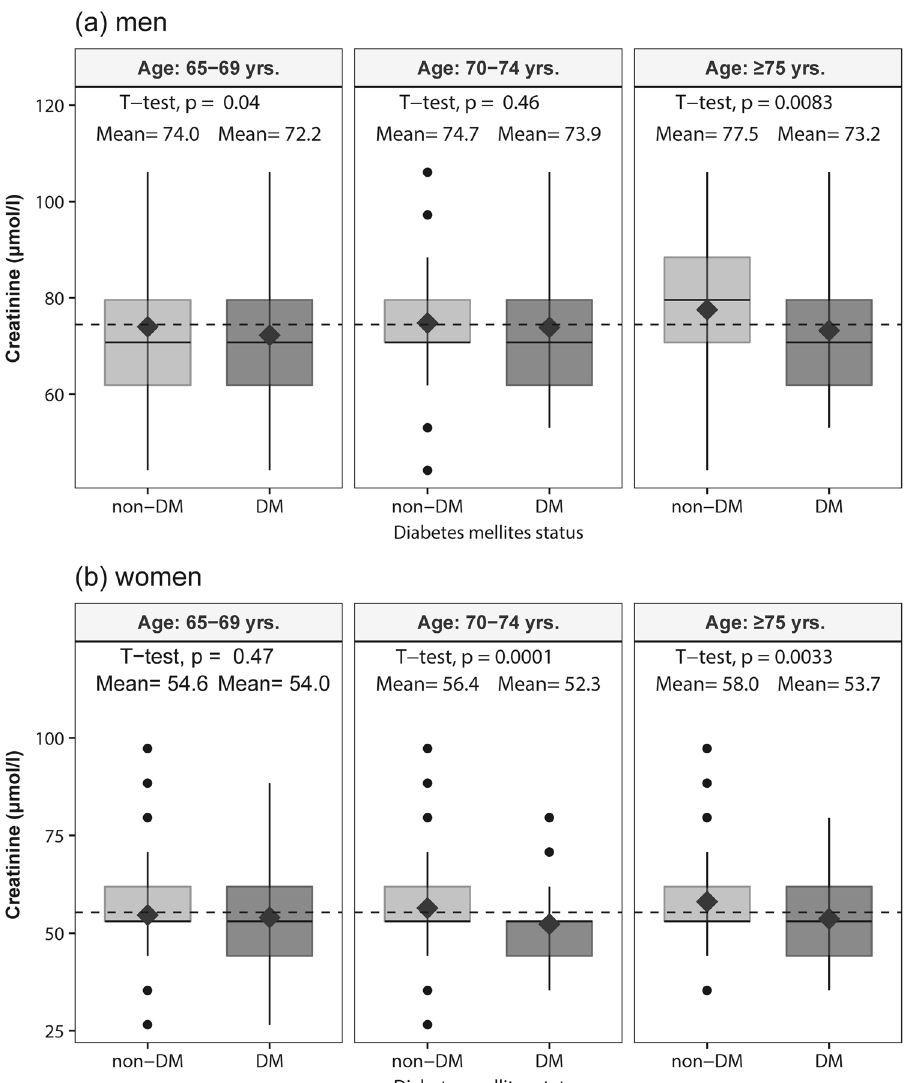
Figure 1. Boxplot of the creatinine levels across age-groups without diabetes (n = 5380) and those with diabetes (n = 753). The dark grey diamonds represent the mean serum creatinine levels. The bottom and top of the box represent the 25th and 75th percentiles, respectively, and the band near the centre of the box is the 50th percentile (median). ‘Whiskers’ represent the maximum and minimum that extend 1.5 times the inter-quartile ranges from the box edges. The vertical dashed line represents the mean creatinine across all participants by sex. DM diabetes